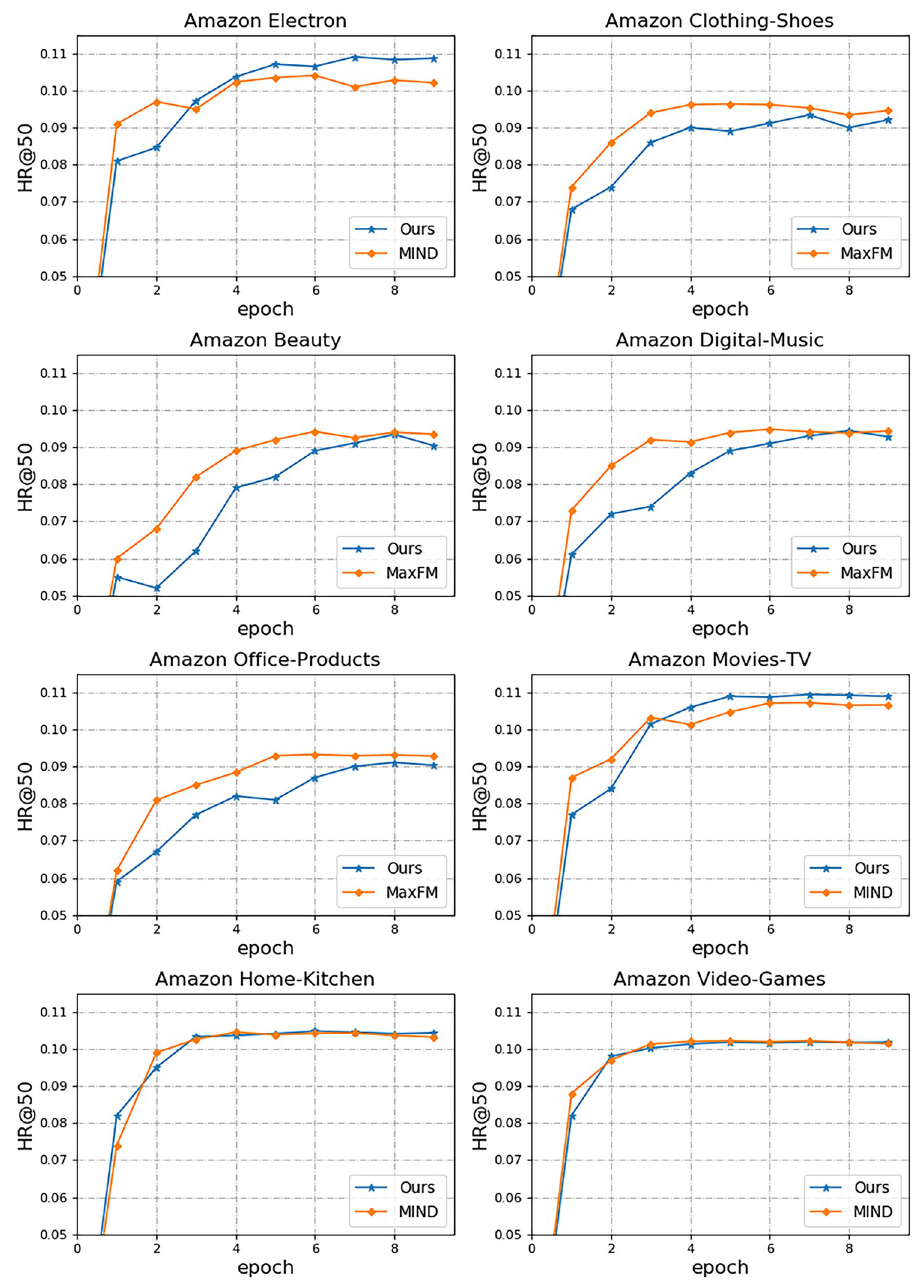
Fig 3. Comparison of HR@50 performance between our model and other models on different